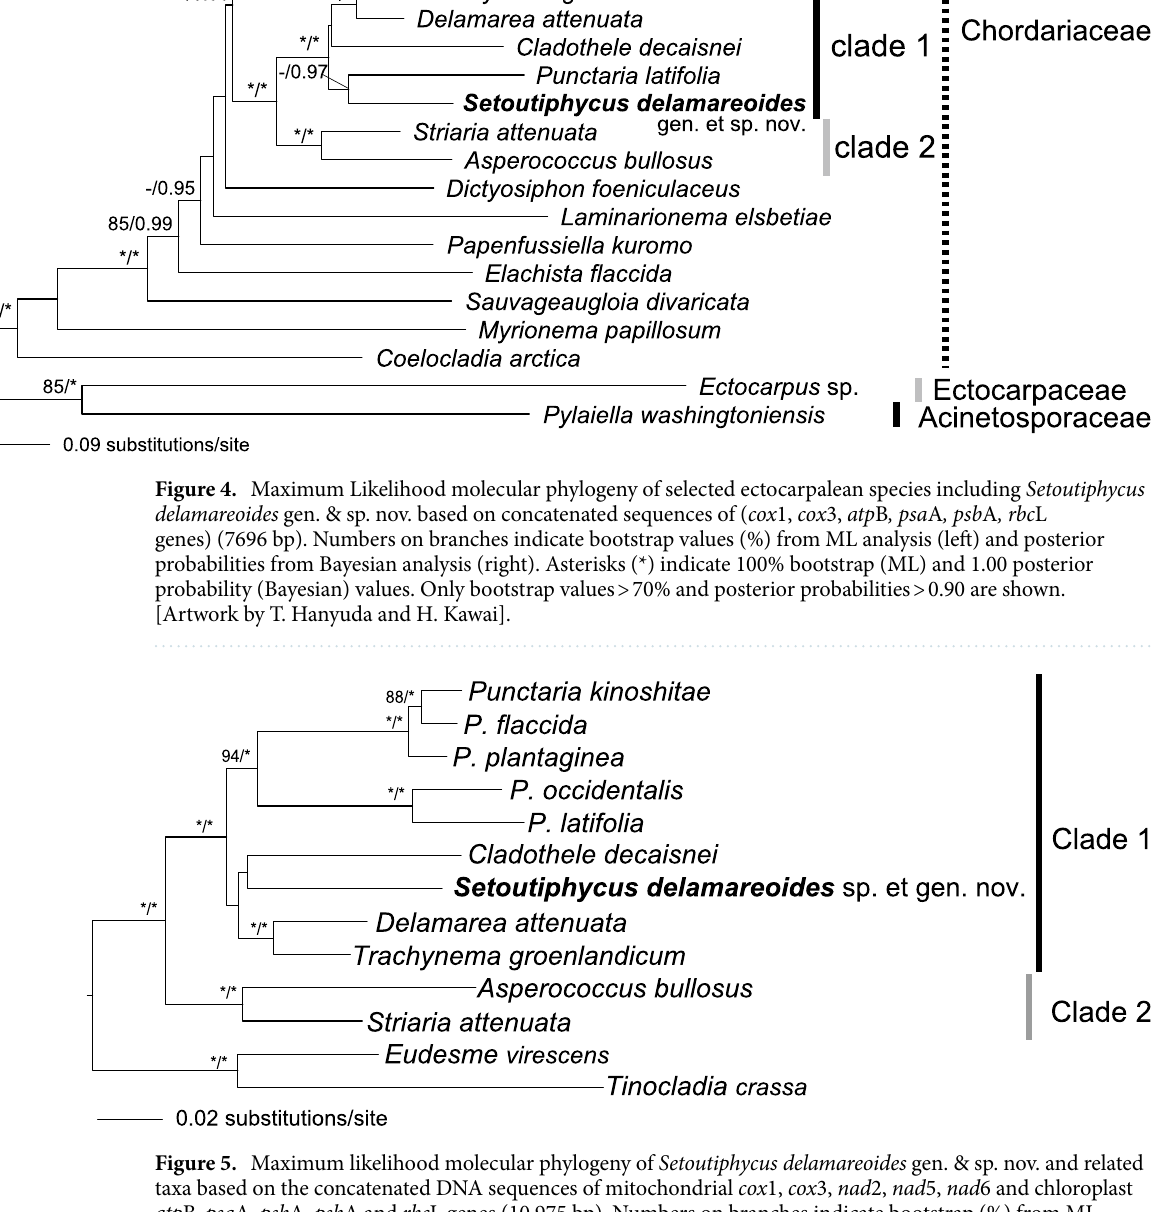
Figure 5. Maximum likelihood molecular phylogeny of Setoutiphycus delamareoides gen. & sp. nov. and related taxa based on the concatenated DNA sequences of mitochondrial cox 1, cox 3, nad 2, nad 5, nad 6 and chloroplast atp B, psa A, psb A, psb A and rbc L genes (10,975 bp). Numbers on branches indicate bootstrap (%) from ML and posterior probability values in Bayesian analyses. Asterisk (*) indicates 100% bootstrap and 1.00 posterior probability values. Only bootstrap values ≥ 70% and posterior probabilities ≥ 0.90 are indicated. [Artwork by T. Hanyuda and H.